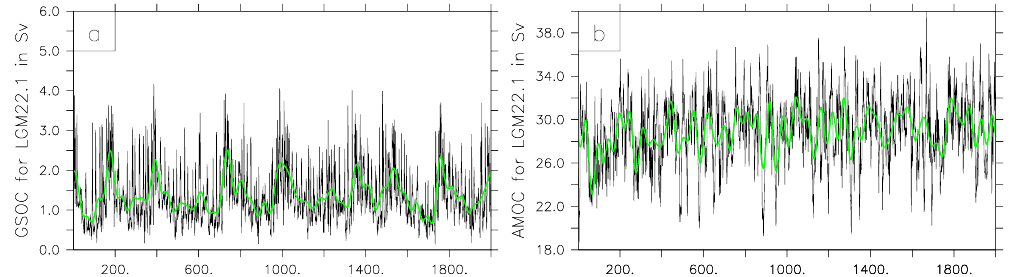
Fig. 11. GSOC (a) and AMOC (b) in Sv for an obliquity of 22.1 but LGM-bathymetry. A low pass filter of 50years was applied for green